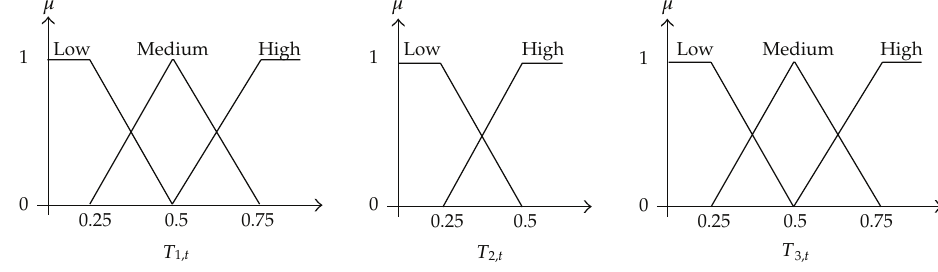
Figure 1: The set of linguistic labels associated with T 1 ,t ,T 2 ,t , and T 3 ,t